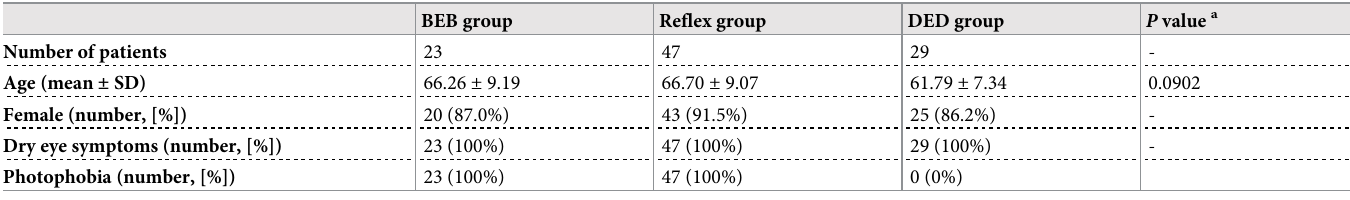
Table 1. Demographic characteristics of patients with benign essential blepharospasm and reflex blepharospasm and dry eye disease control.